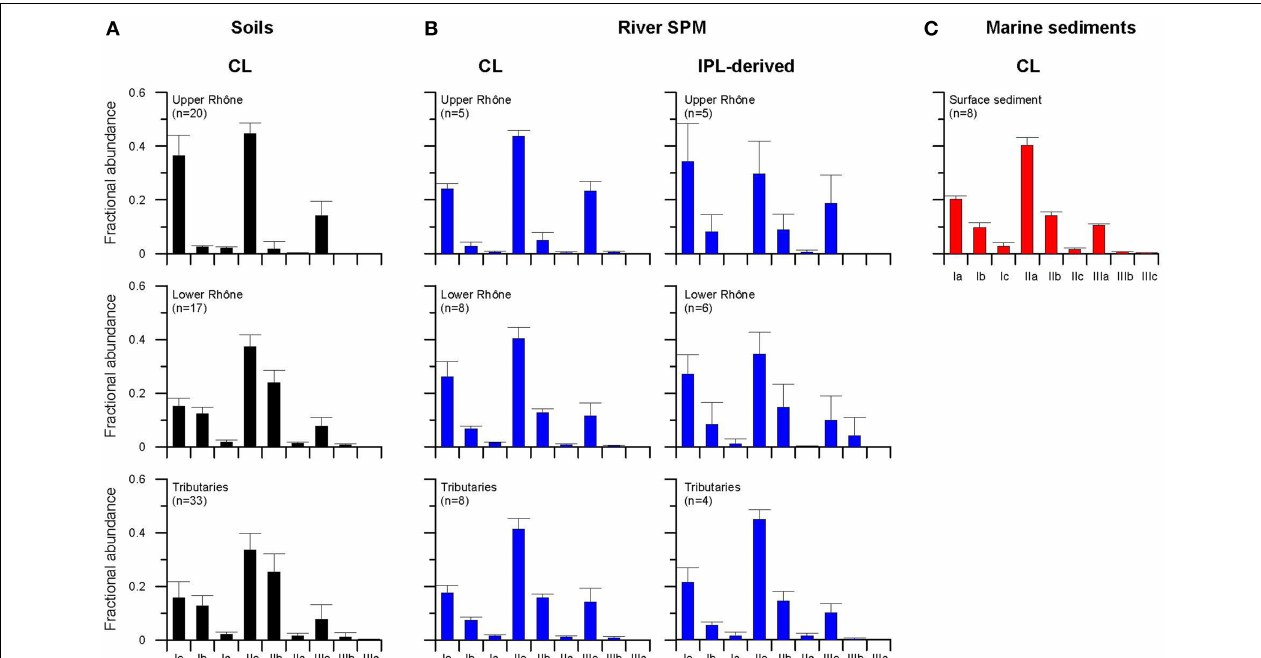
FIGURE 3 | Average CL brGDGT distribution of (A) soils, (B) river SPM, and (C) marine sediments.